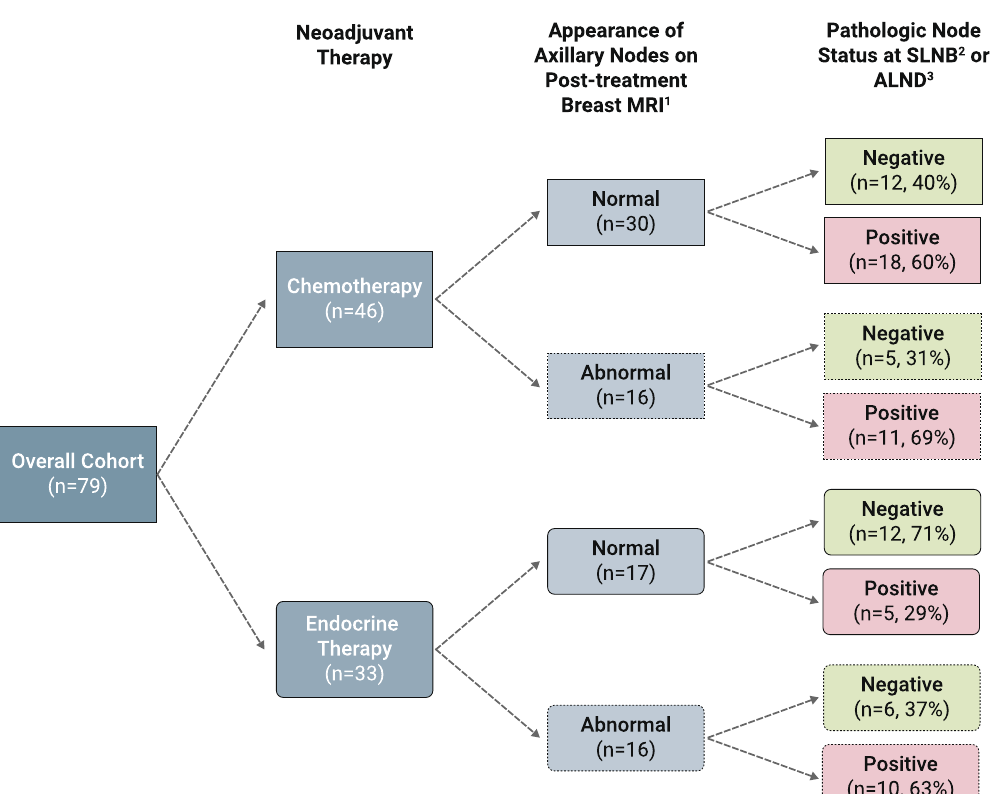
Fig. 2 Pathologic node status by type of neoadjuvant therapy and MRI appearance of axillary nodes. Appearance of axillary nodes on MRI and subsequent pathologic node status following neoadjuvant chemotherapy or neoadjuvant endocrine therapy. 1 Appearance of axillary nodes was determined based on nodal BIRADS features. 2 SLNB: sentinel lymph node biopsy. 3 ALND: axillary lymph node